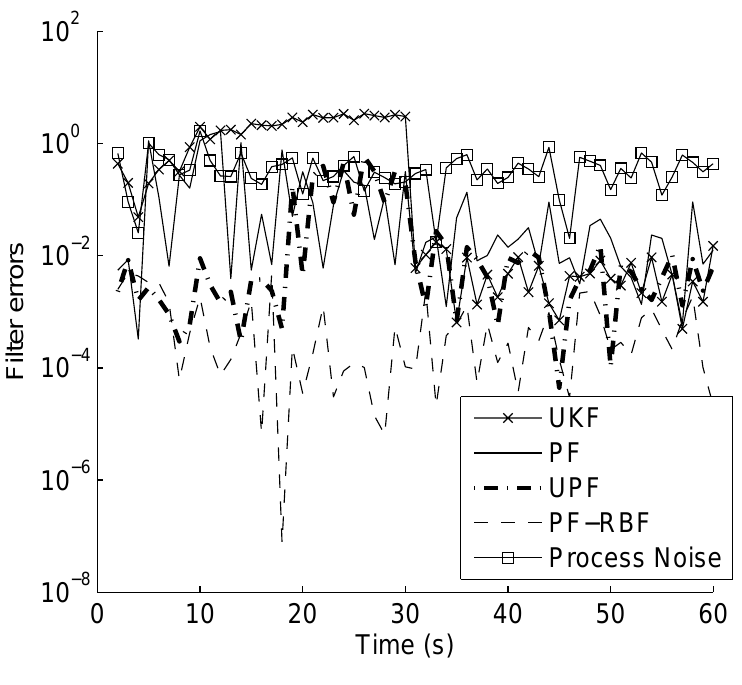
Figure 3. Errors of different filters versus the process noises in a single run.